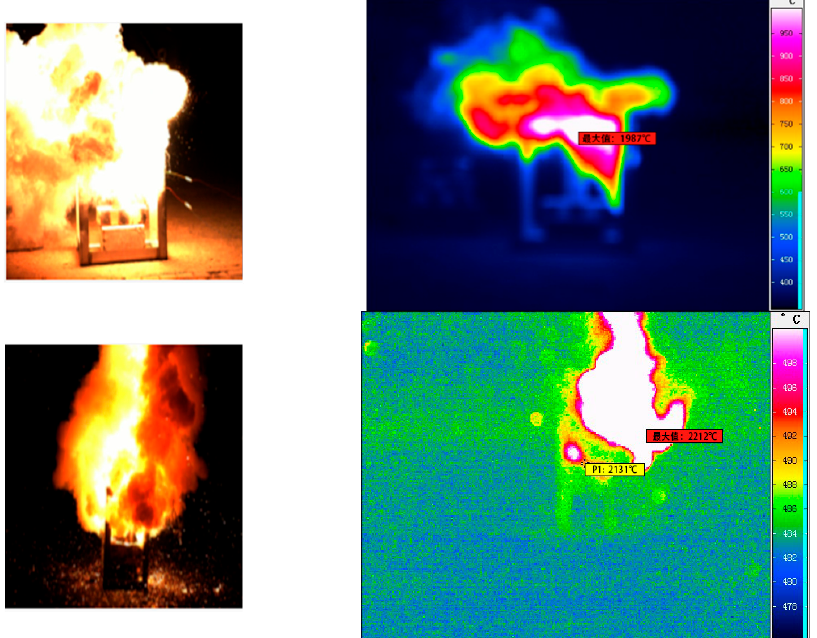
Figure 4. Images of the high-speed camera and infrared camera of the highest temperature moments of Tests 2 and 5.